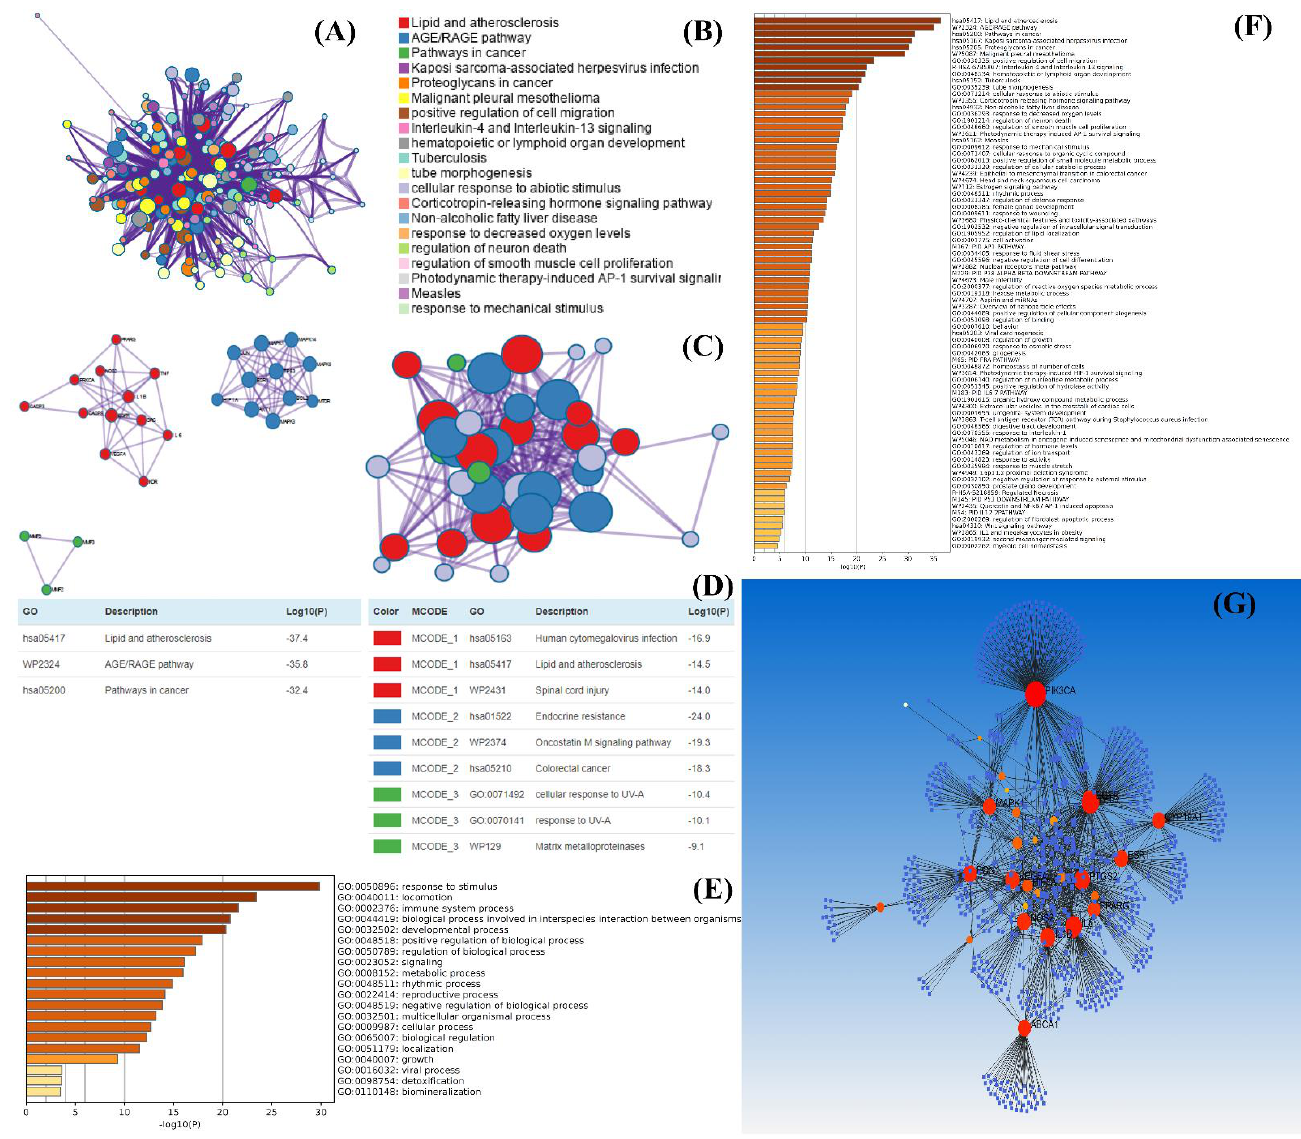
Figure 4. Representation of gene and disease association analysis as part of gene ontology analysis. ( A , B ) represent the enrichment of the analyzed genes and their pathophysiological role through different pathways, ( C ) represents the enrichment of genes based on their pathophysiological role, while ( D ) represents the enrichment scale of the genes and their role in diseases. ( E ) represents the gene ontology analysis of the selective genes, and ( F ) represents the DisGeNET analysis. This analysis was conducted as an example through the Metascape tool. ( F ) represents the gene and disease association network among different genes while ( G ) represents large nodes with high enrichment of the gene with nodes of diseases. This analysis was conducted through the Network analyst tool.